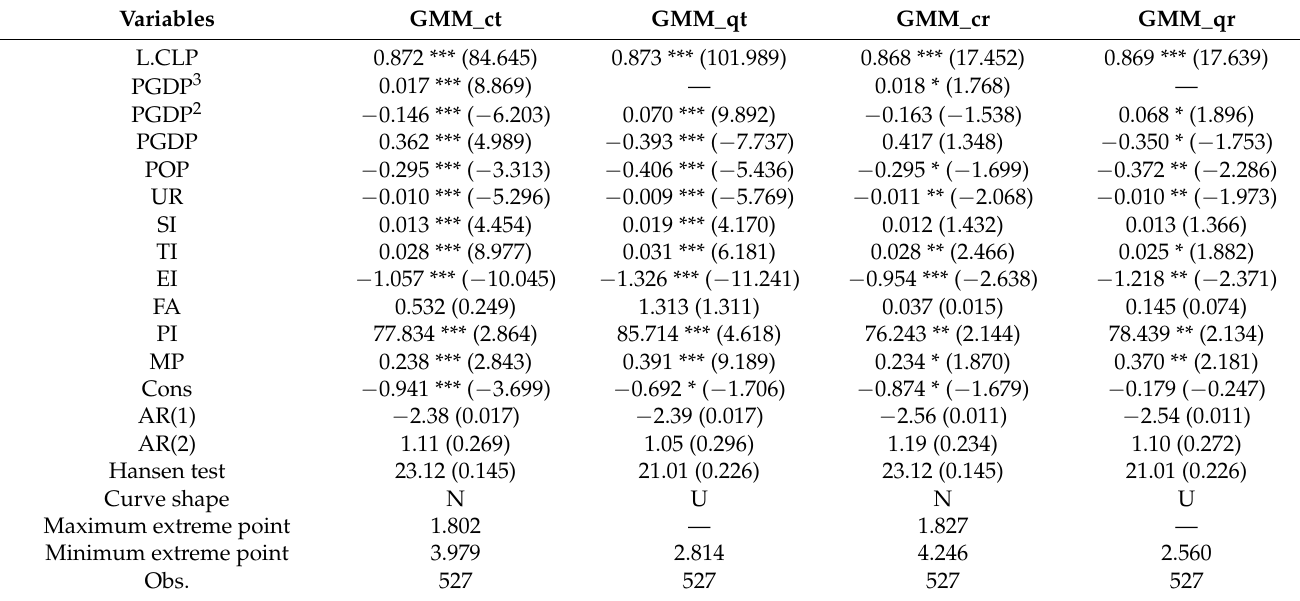
Table 9. Estimation results with generalized moments.